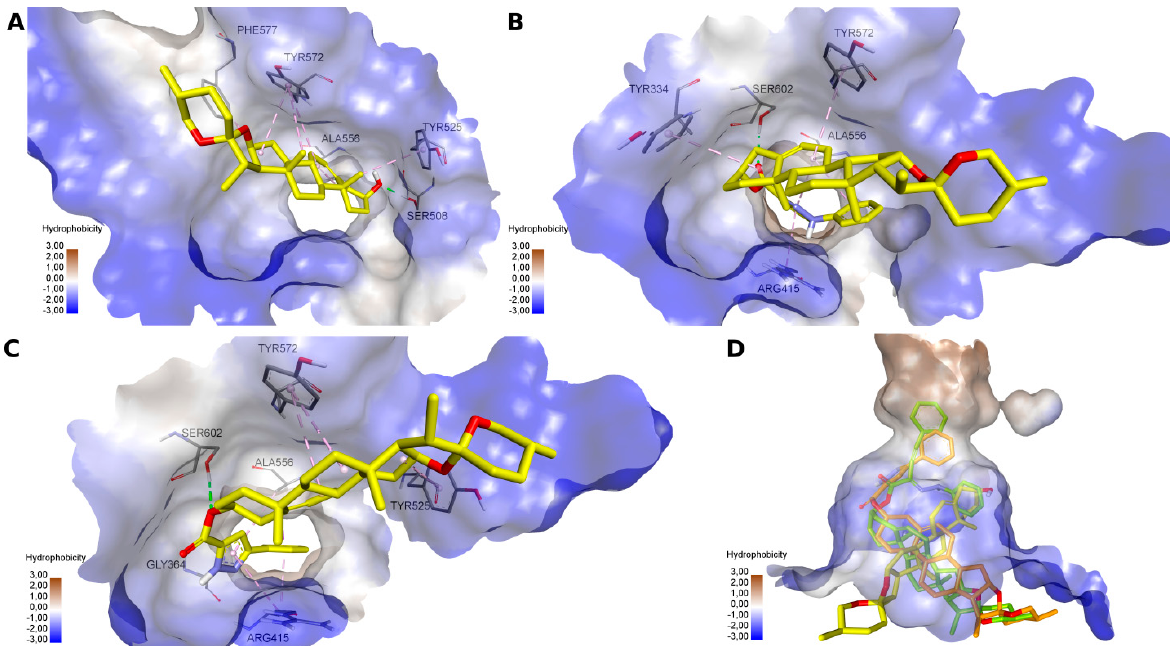
Figure 5. Docking in the Kelch domain of Keap1. Noncovalent interactions of compounds ( 1 —( A ), 15 —( B ), 23 —( C )) are shown by dotted lines: green—hydrogen bonds, purple—hydrophobic interactions. ( D )—Superposition of structures at the binding site, structures colored by yellow— 1 , green— 15 , orange— 23 .